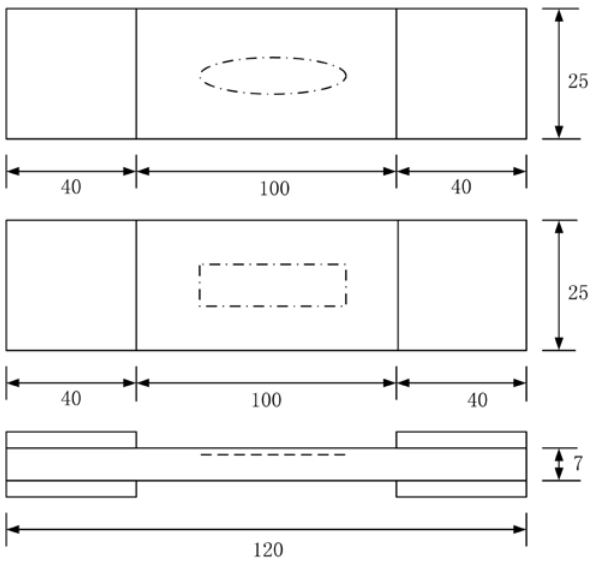
Figure 4: Dimensions of the laminated plate with elliptical or rec- tangular delaminations